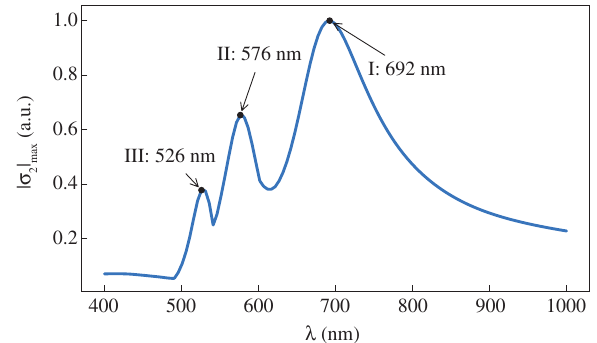
Figure 5: Simulated spectrum of the maximum surface charge density of a spherical gold dimer with a gap width of 2 nm on a silicon substrate with 1 nm of silicon oxide. Both spheres have a diameter of 90